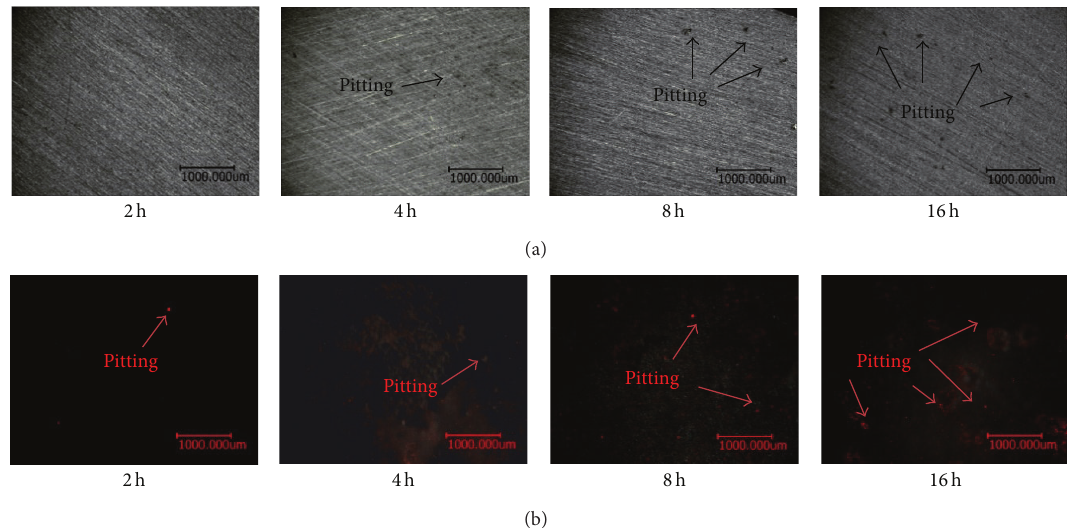
Figure 6: Optical images (a) and fluorescence images (b) observed at different immersion times during weight-loss test.